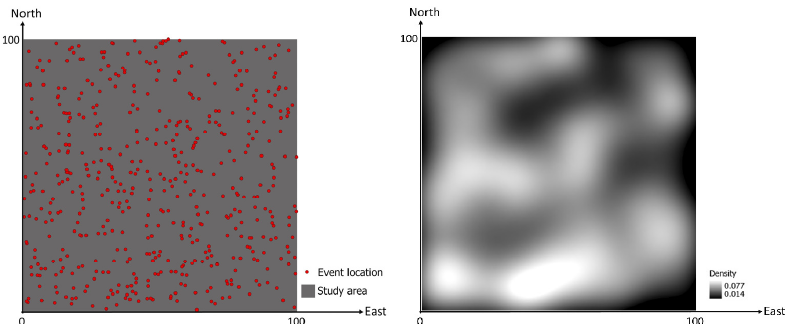
Figure 5. An example synthetic dataset ( left ) containing n = 500 random event locations in the rectangular study area discretized into a 10,000 rows × 10,000 columns raster (cell size 0.1) for density estimation, and the density raster ( right ) estimated with fixed bandwidths h = 7.668 determined using the ‘rule-of-thumb’ method. Moreover, to demonstrate the capability of the extended GPU-parallel KDE to handle applied to a real-world dataset containing n = 13,806,513 sampling event locations (i.e., birding sites) (Figure 6) obtained from the eBird citizen science project [36,37] for estimat- ing 1000- or 500-m resolution probability density rasters covering the world between lat- itudes 60° S and 75° N.